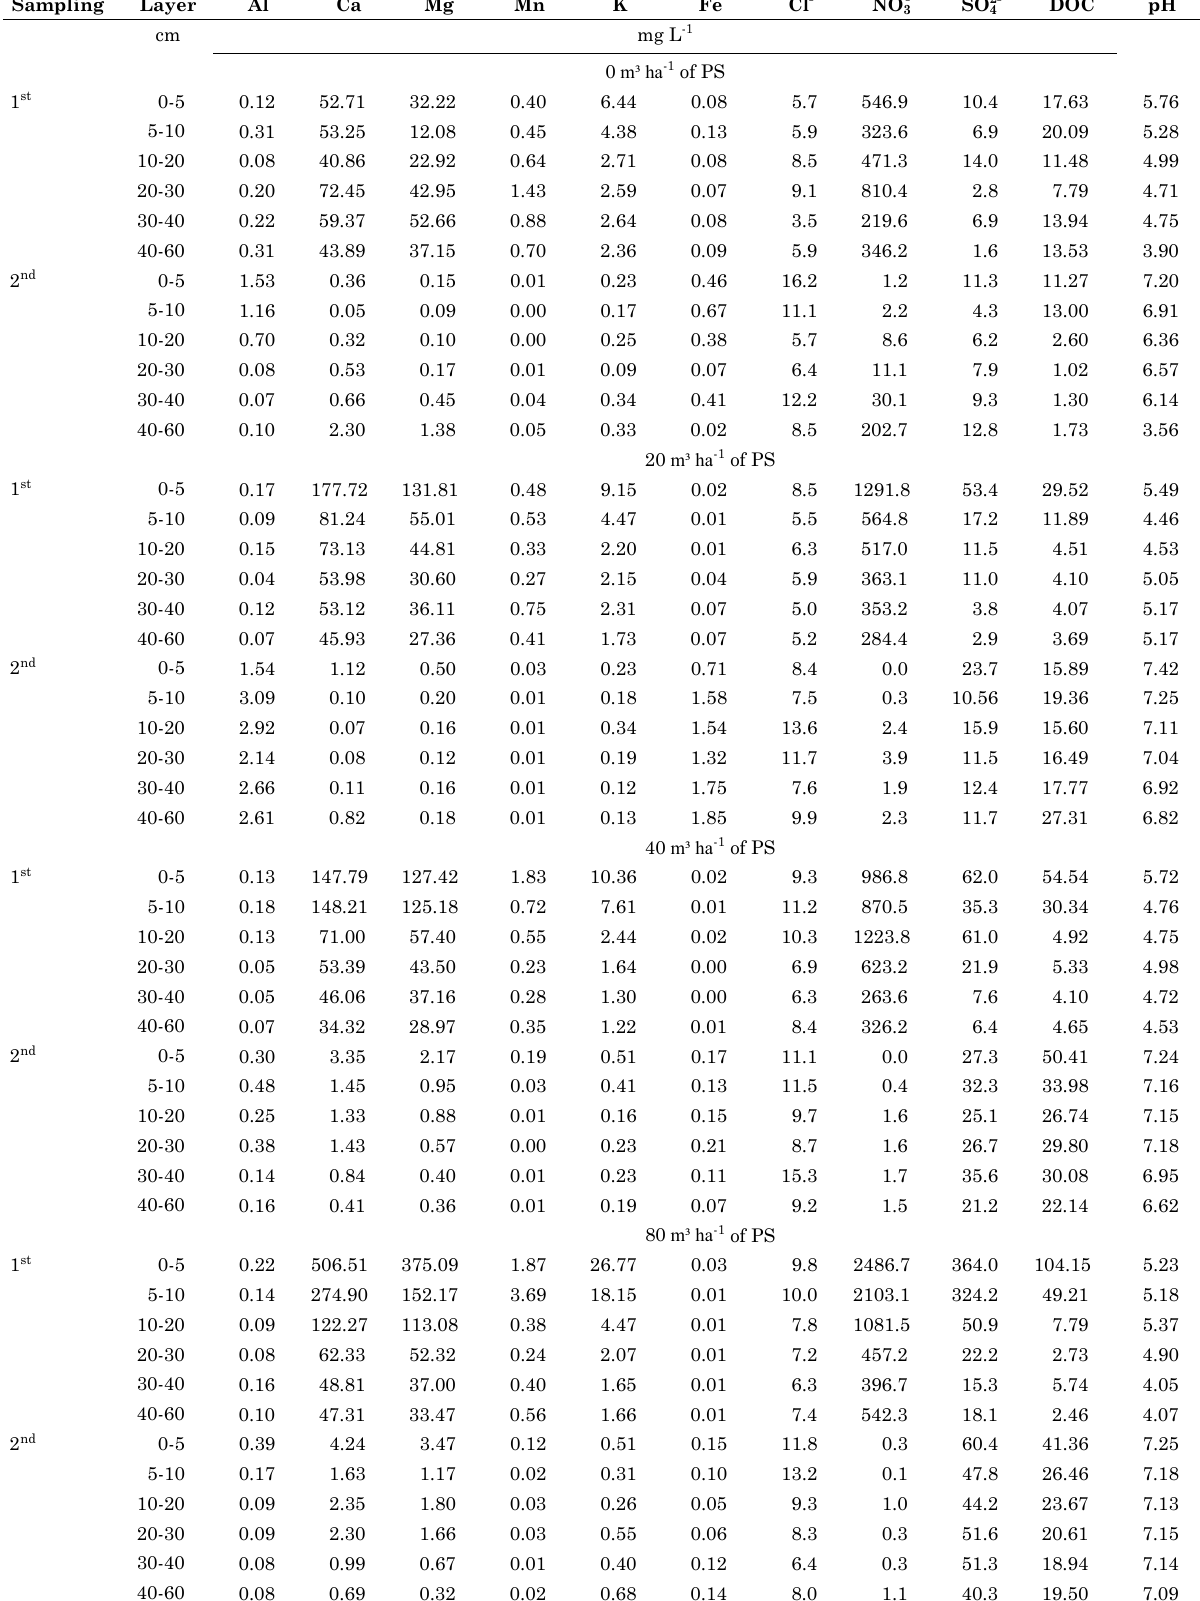
table 1. chemical properties in the soil solution in the 1 st and 2 nd sampling of a typic hapludalf soil treated with 0, 20, 40, and 80 m 3 ha -1 of pig slurry (Ps)